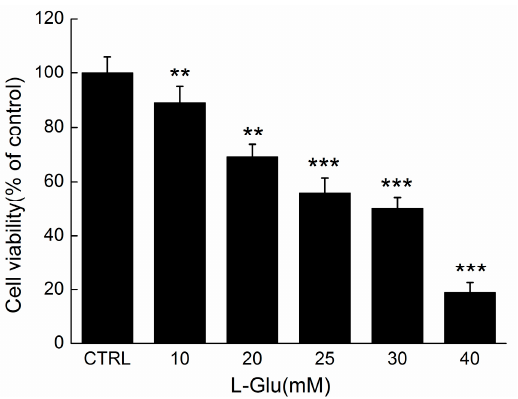
Figure A2. Effects of various concentrations of L -Glu on the viability of DPC12 cells. DPC12 cells were exposed to 10–40 mM of L -Glu for 24 h. Data were expressed as a percentage of corresponding control cells and means ± S.D. ( n = 6). ** p < 0.01, *** p < 0.001 versus control cells.